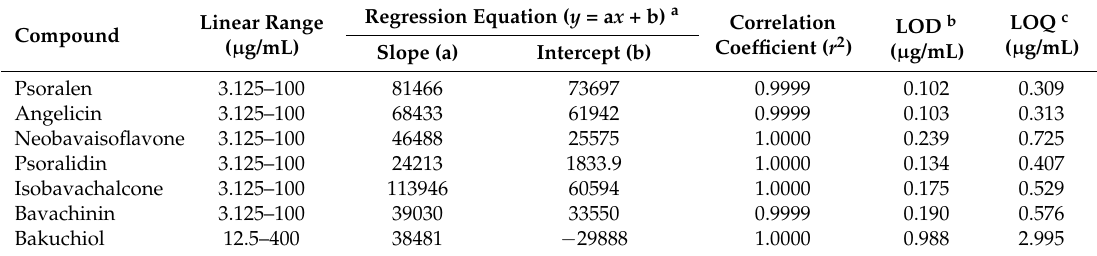
a y = a x + b, y means peak area and x means concentration ( µ g/mL); b LOD (Limit of detection): 3.3 × (SD of the response/slope of the calibration curve); c LOQ (Limit of quantitation): 10 × (SD of the response/slope of the calibration curve).